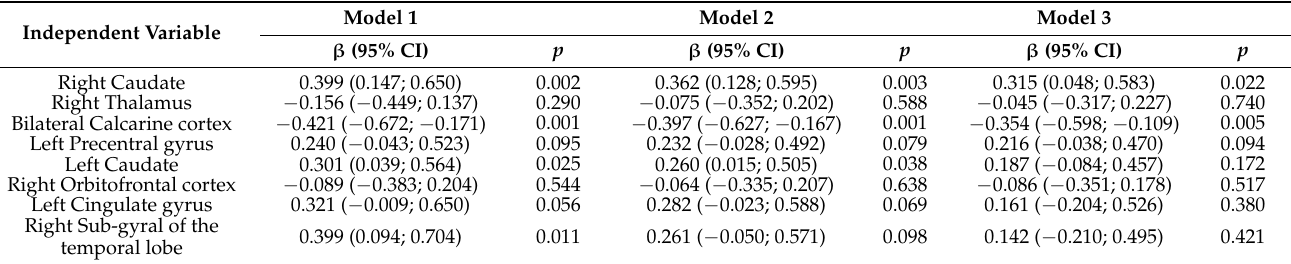
Table 3. Association between PSQI score and mean gray matter volume in CSVD